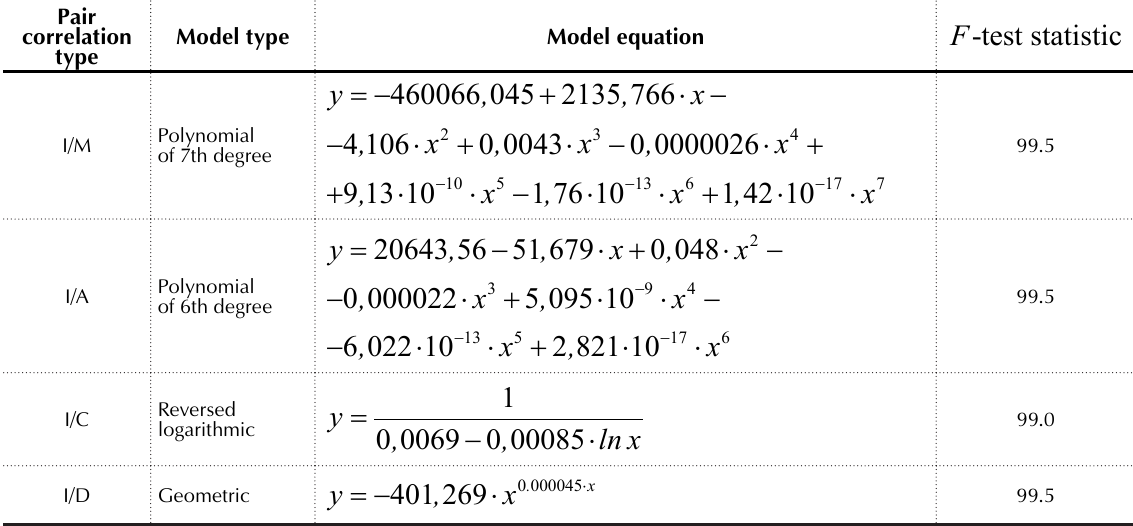
Table 3. Consolidated results of the pair correlation of CU’s income and the factors affecting it Pair correlation Model type Model equation type